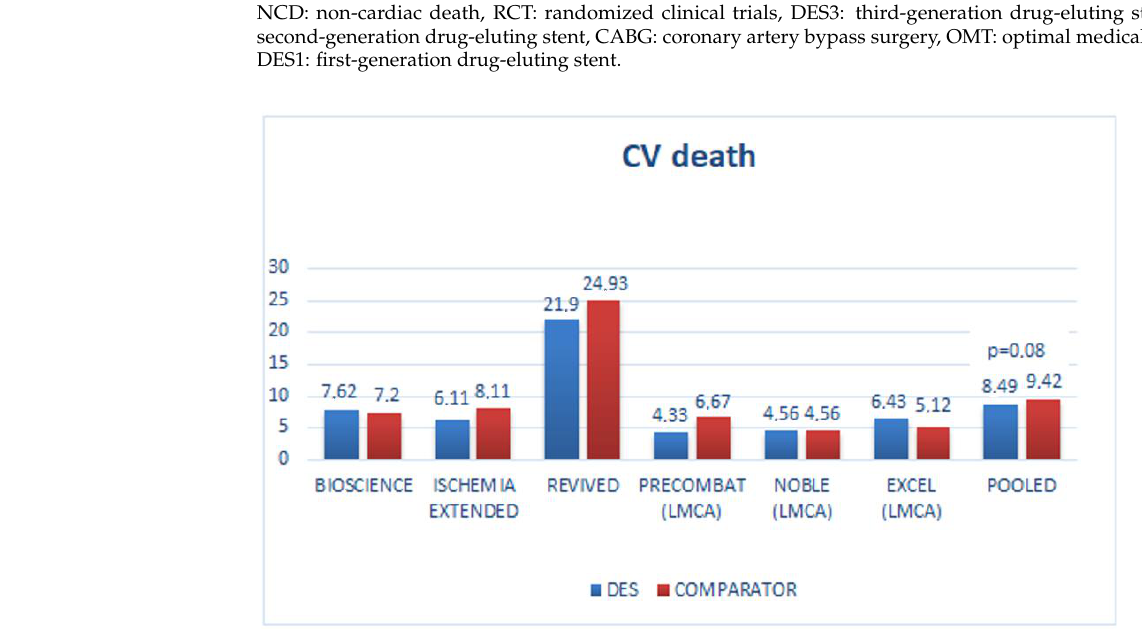
Figure 1. Randomized clinical trials with drug-eluting stents (DES) and cardiovascular death (CV- death). The last bar is the average of trial results. No significant differences in cardiac death ( p = 0.08 in favor of DES). BIOSCIENCE: randomized third-generation DES vs. second-generation DES; IS- CHEMIA Extended: randomized invasive strategy (DES in 74%) vs. optimal medical treatment (OMT); REVIVED: randomized DES vs. OMT; PRECOMBAT: randomized DES vs. CABG in left main coronary artery (LMCA); NOBLE: randomized DES vs. CABG in LMCA; EXCEL: randomized DES vs. CABG in LMCA.